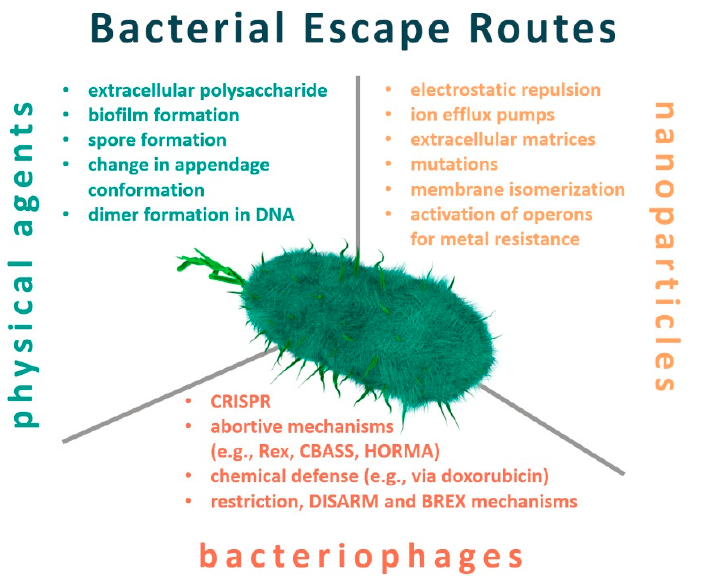
Figure 1. Escape routes utilized by bacteria to deal with non-antibiotic antibacterial agents, i.e., physical factors, nanoparticles, and